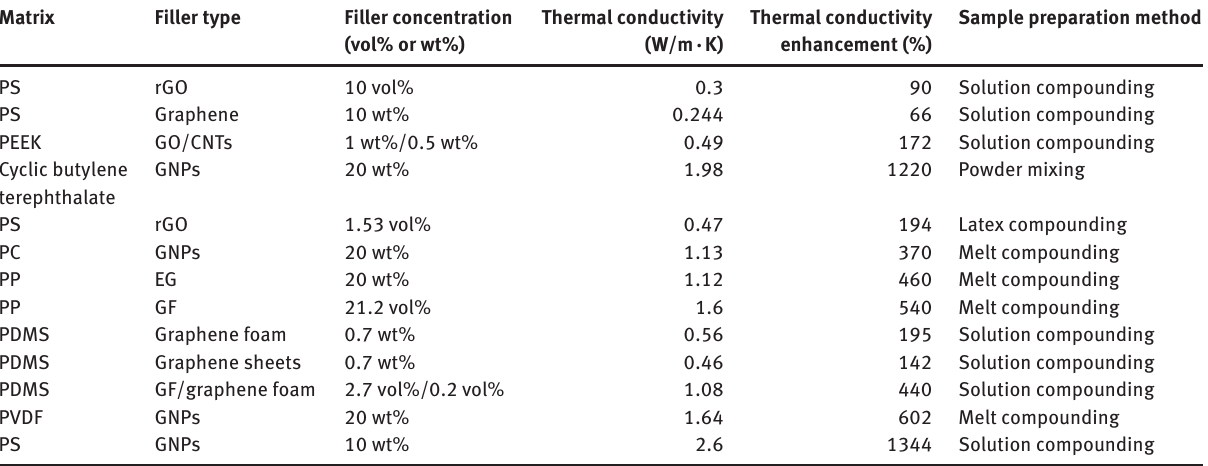
Table 4: Comparison of the thermal conductivity of different polymeric composites [22].